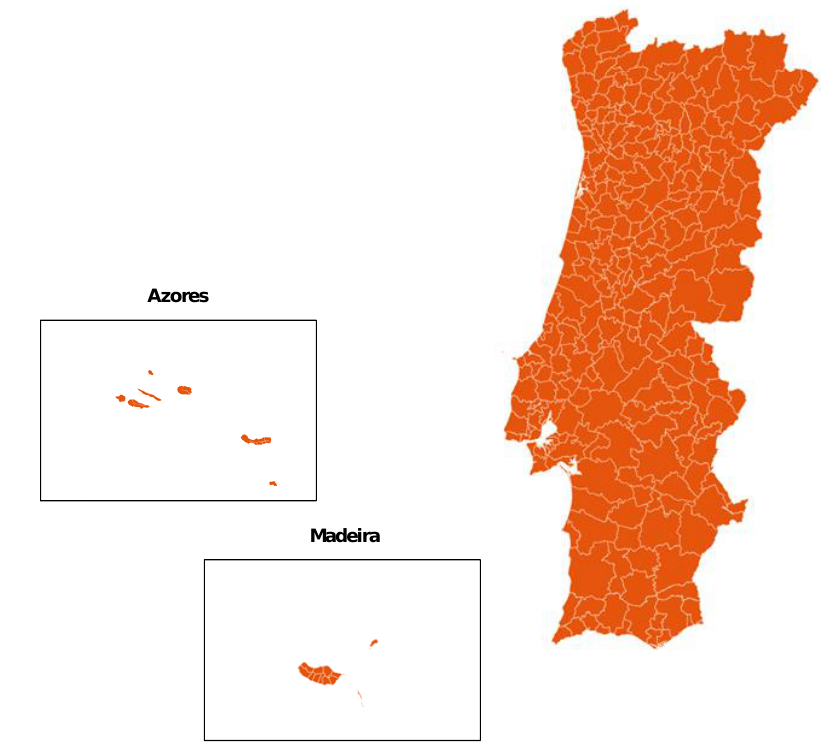
Figure 7. Portuguese municipalities. The authors created this map. Table 2. Description of the